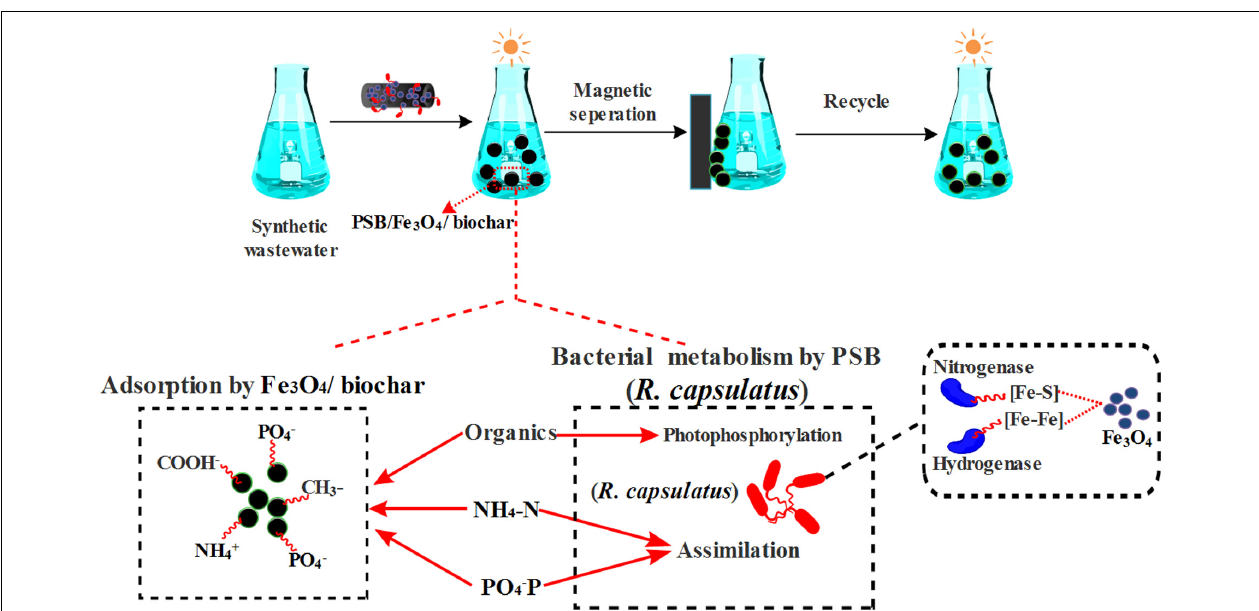
FIGURE 6 | Possible nutrient removal mechanisms by the PSB/Fe 3 O 4 /biochar.